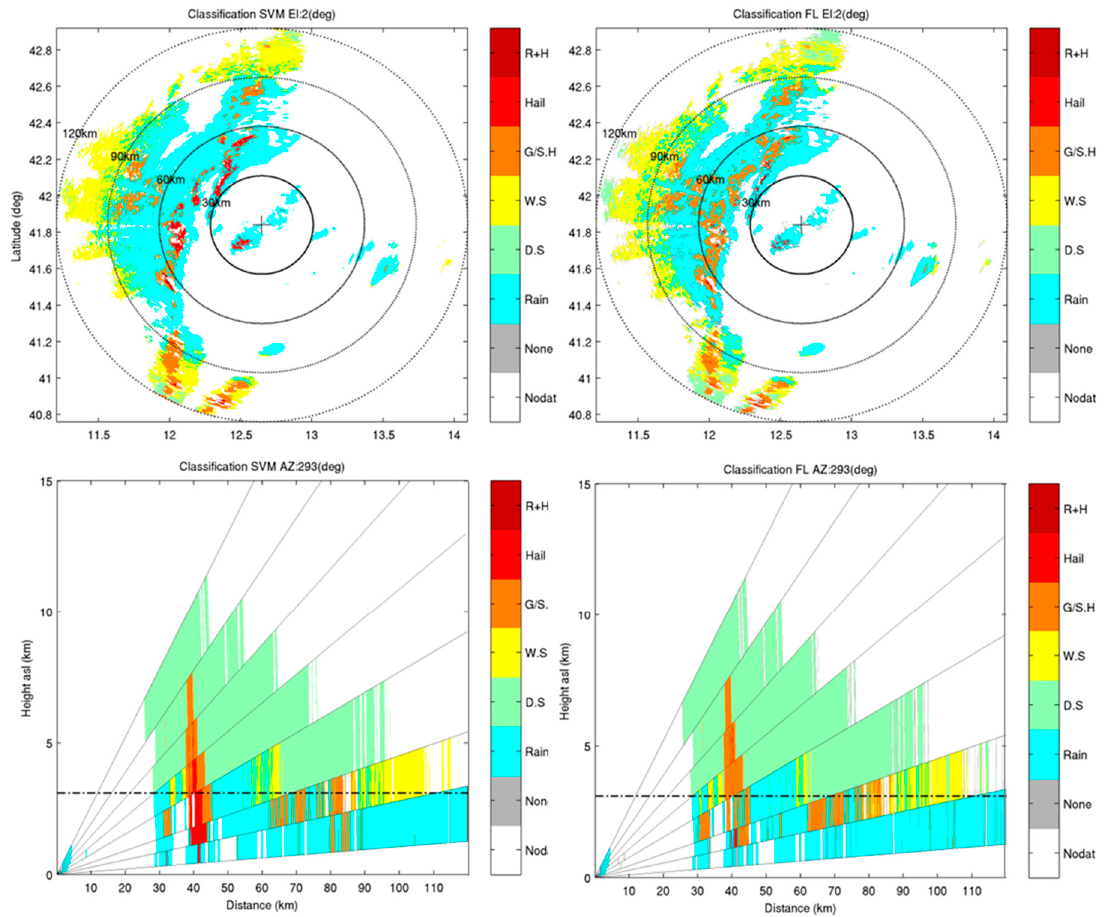
Figure 4. Hydrometeor classification applied to 12 October 2015 at 1305 UTC case study: SVM approach in first column and FL in second column. Upper panels show the PPI at 1.6° and bottom panels show the pseudo RHI for 66° azimuth.